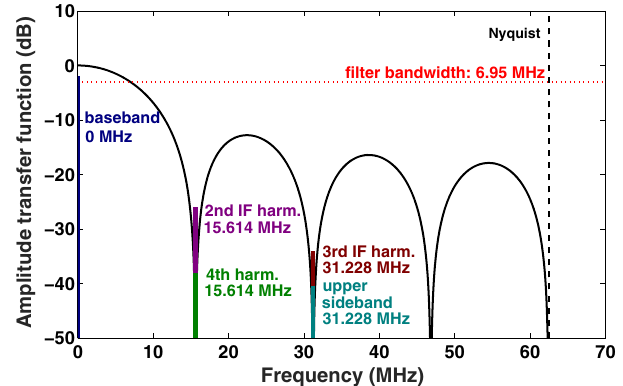
FIG. 24. Amplitude transfer function of the non-IQ digital filter of the llrf system.